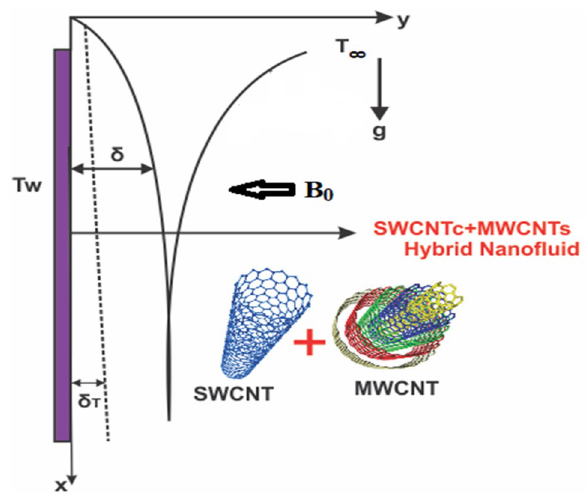
Figure 1. Graphical view of the flow